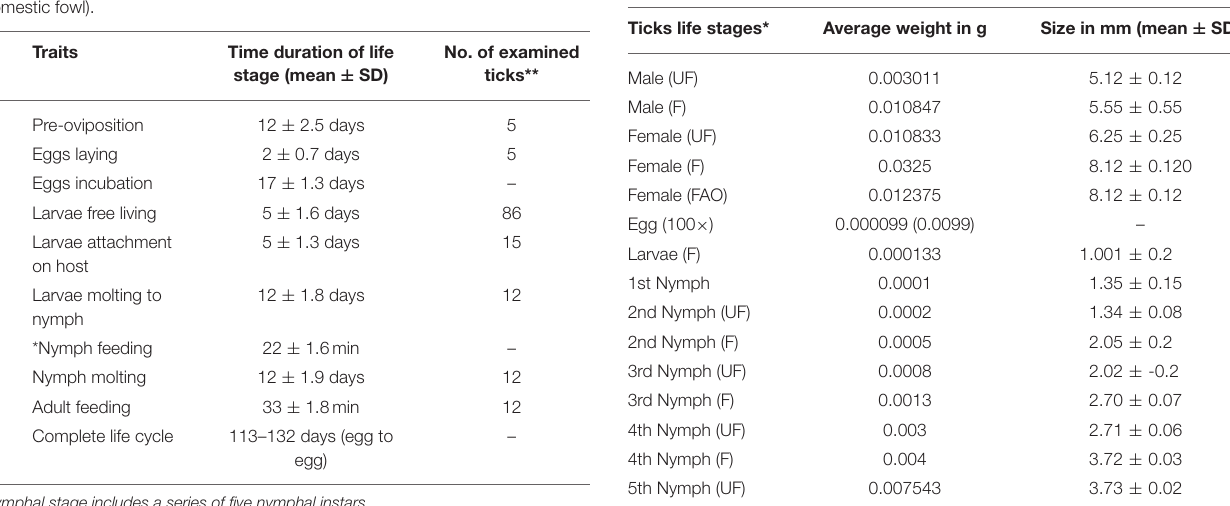
TABLE 5 | Body measurements of Argas persicus